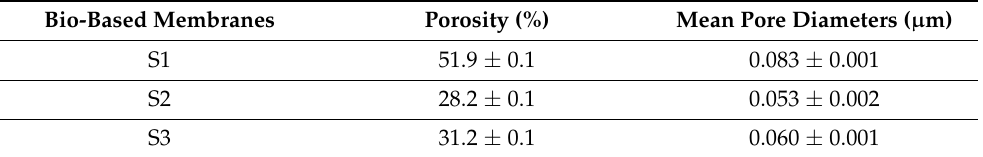
Table 2. Porosity and mean pore diameters of the bio-based membranes